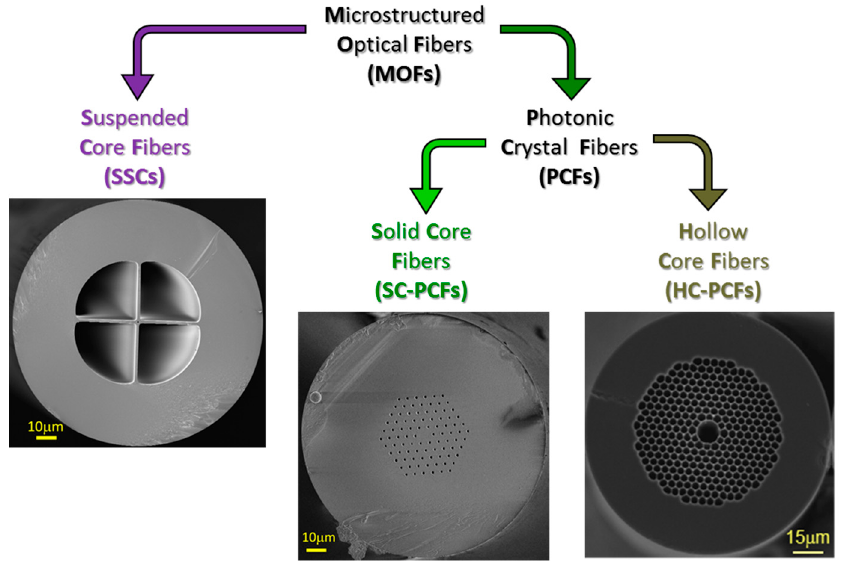
Figure 1. Classification of the different types of microstructured optical fibers (MOFs) based on their structures.